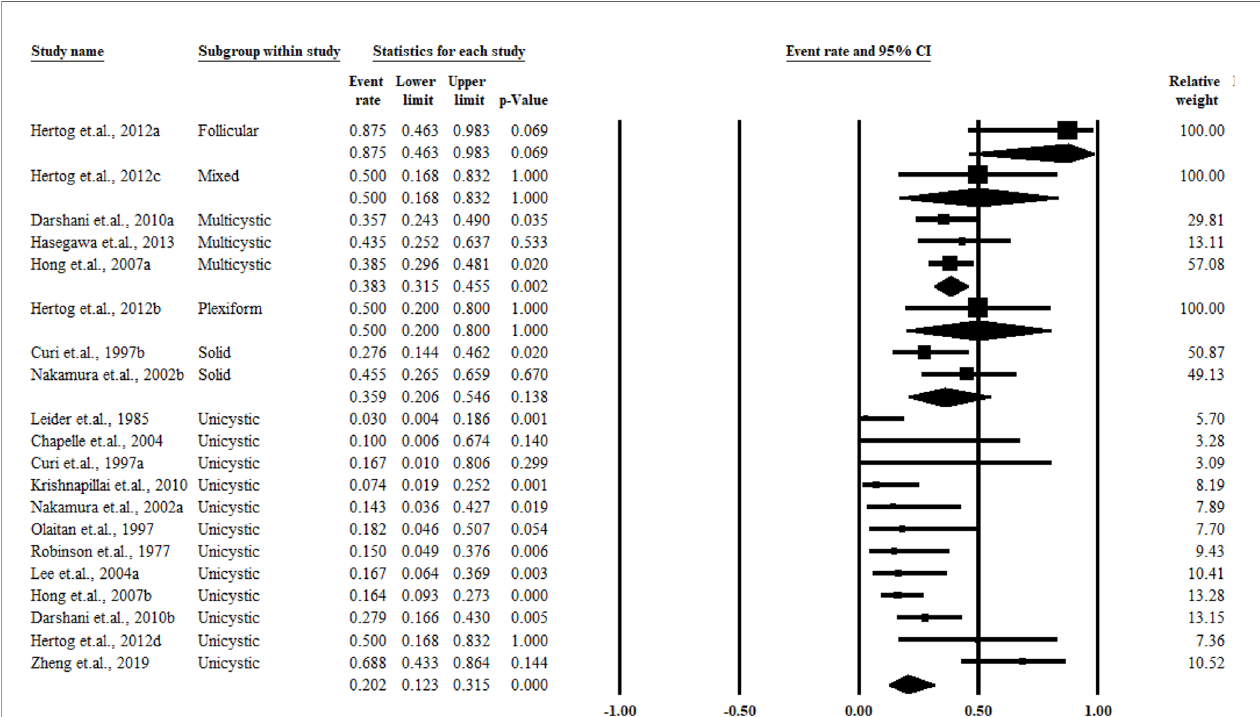
FIGURE 4 | Summary of the conservative treatment recurrence rate strati fi ed by the histological classi fi